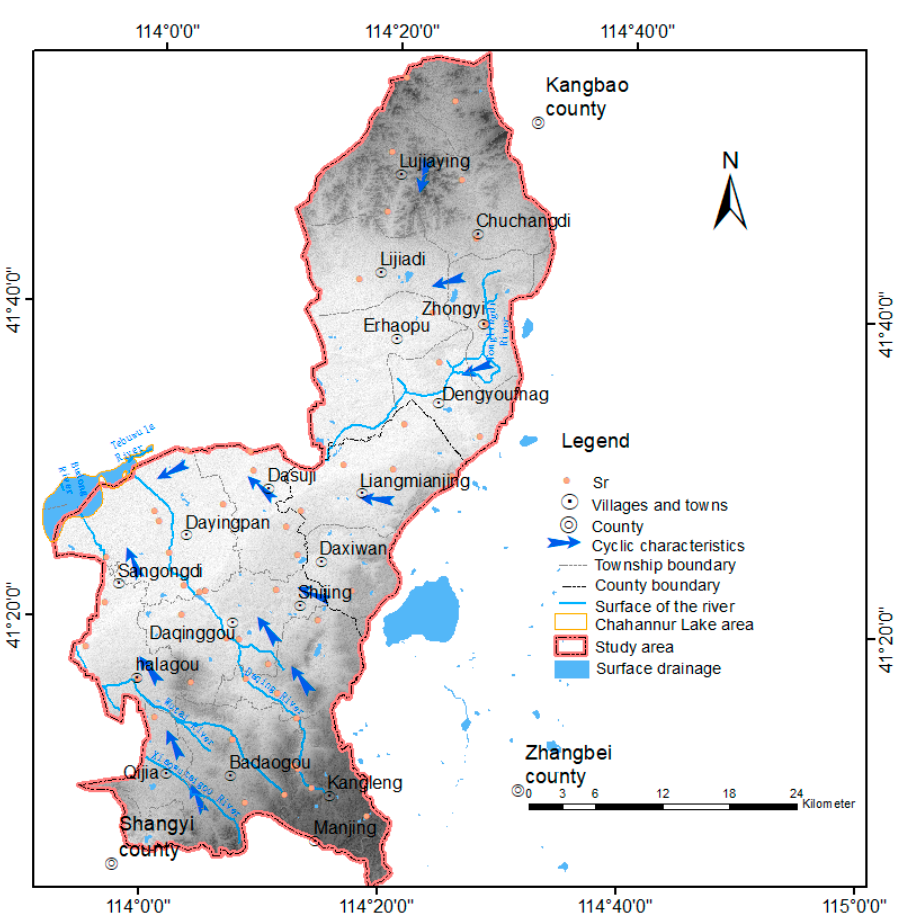
Figure 9. The characteristics of groundwater circulation.